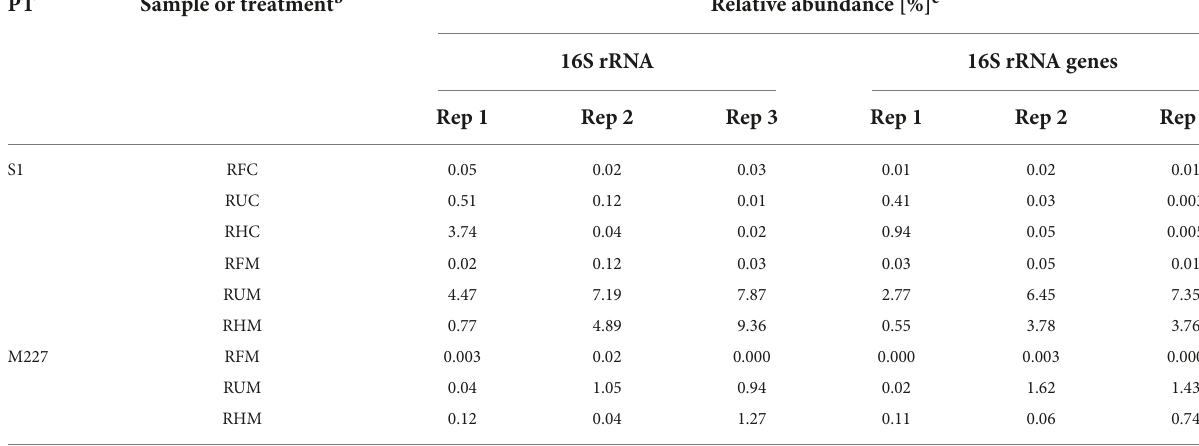
TABLE 4 Relative abundances of potentially acetogenic phylotypes in fresh and anoxically incubated roots a . PT Sample or treatment b Relative abundance [%] c 16S rRNA